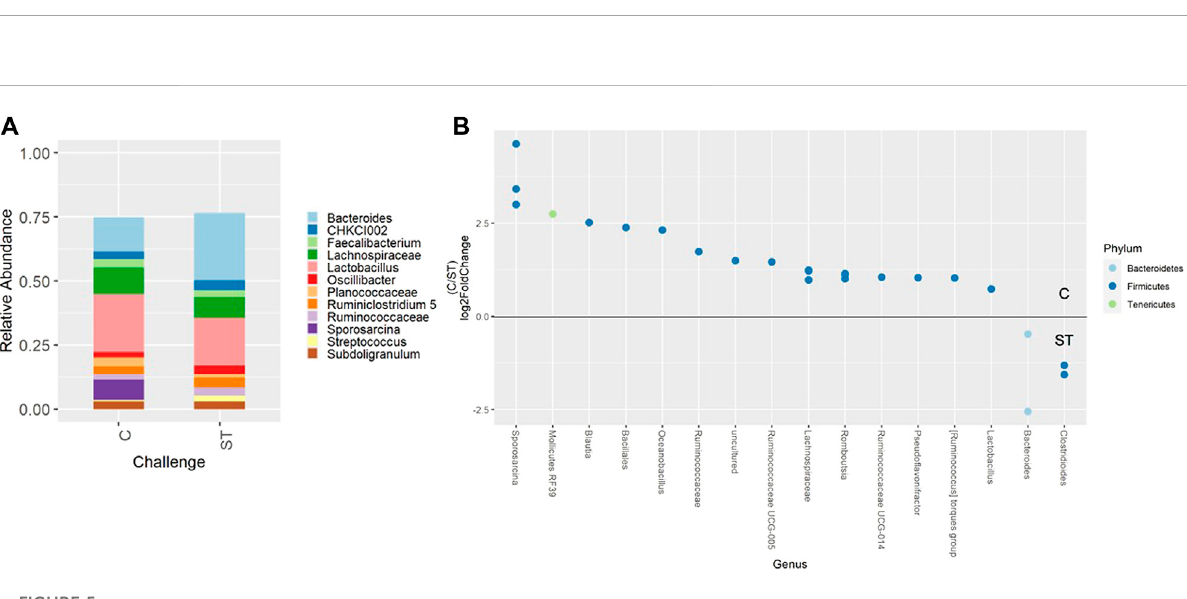
FIGURE 4 The effect of Salmonella challenge on beta diversity measures in the cecum. Signi fi cant dissimilarity was seen in Bray-Curtis (A,D) , unweighted Unifrac (B,E) , and weighted Unifrac (C,F) for 17 (A – C) and 24-day-old (D – F) broilers. Red represents control (C) broilers while blue represents Salmonella Typhimurium challenged (ST)